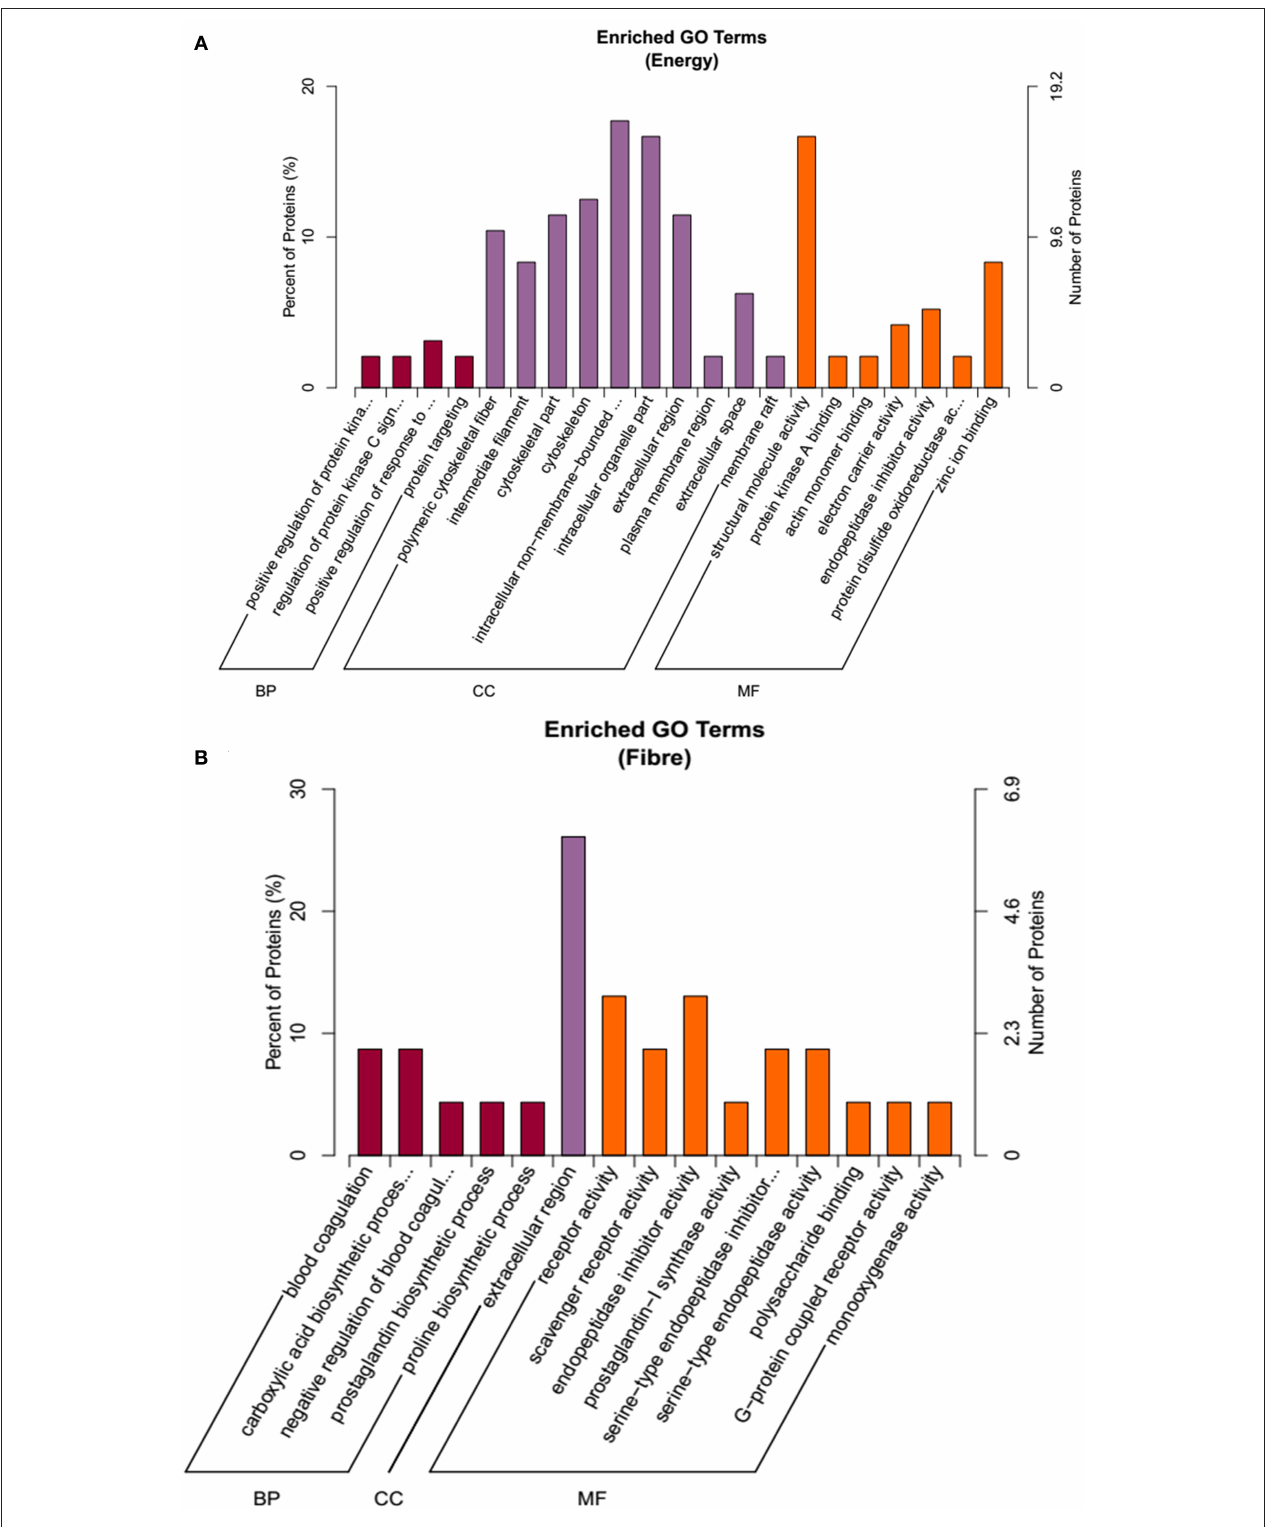
FIGURE 4 | The functional enrichment of Gene Ontology (GO) annotation of the DEPs. (A) Energy differential protein GO annotation diagram. (B) Fiber differential protein GO annotation diagram.